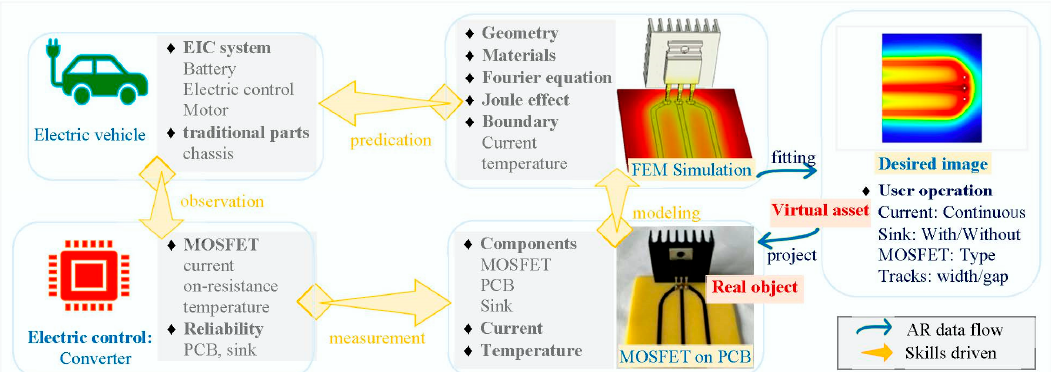
Figure 6. Four skills-driven design of AR experiment content on MOSFET thermal management, where observation, measurement, modeling, and predication are incorporated into the implementa- tion of virtual assets and real objects.